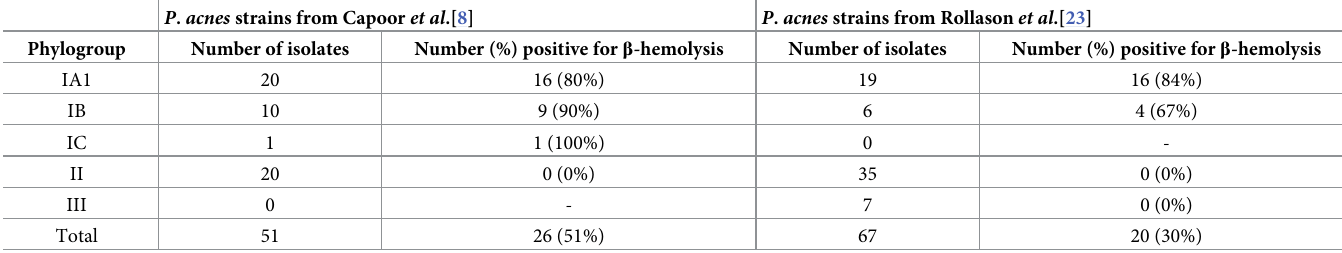
Table 1. Phylogroup-specific distribution of β -hemolysis among P . acnes isolated from disc tissue. P . acnes strains from Capoor et al